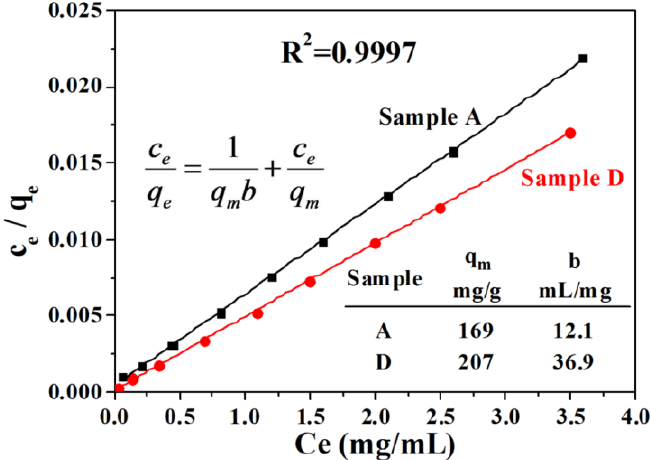
Figure 6. The Hb protein adsorption properties of Sample A (pH 5) and Sample D (pH 11). The linear relationship between c